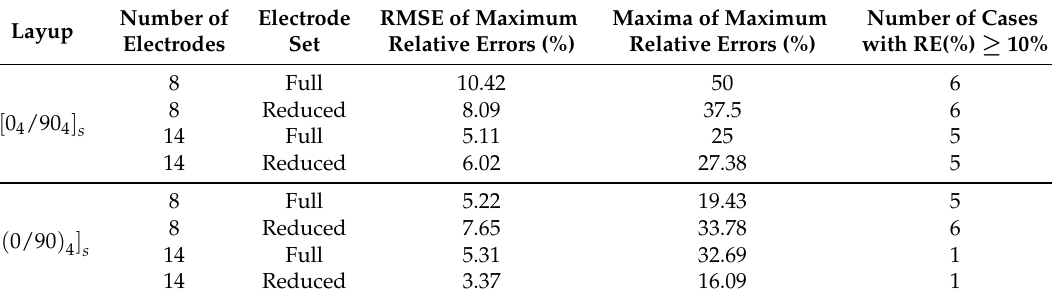
Table 4. Summary of inverse identification